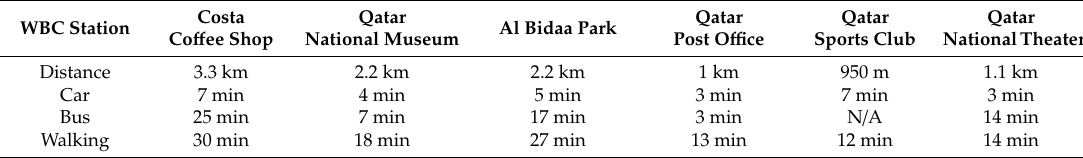
Table 2. The distance via transportation modes between West Bay Metro stations and nearby landmarks.